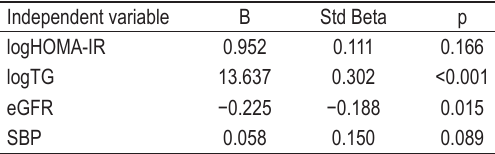
TABLE 3. Multiple regression analysis with RBP4